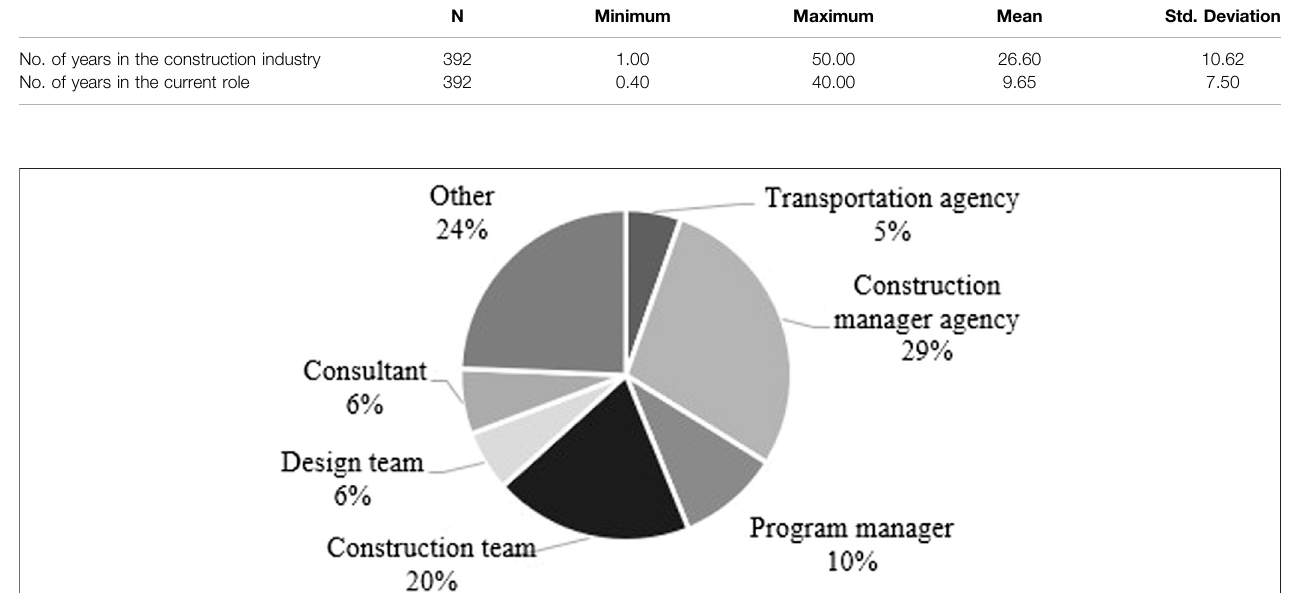
FIGURE 2 | Role of respondents ’ organization in the